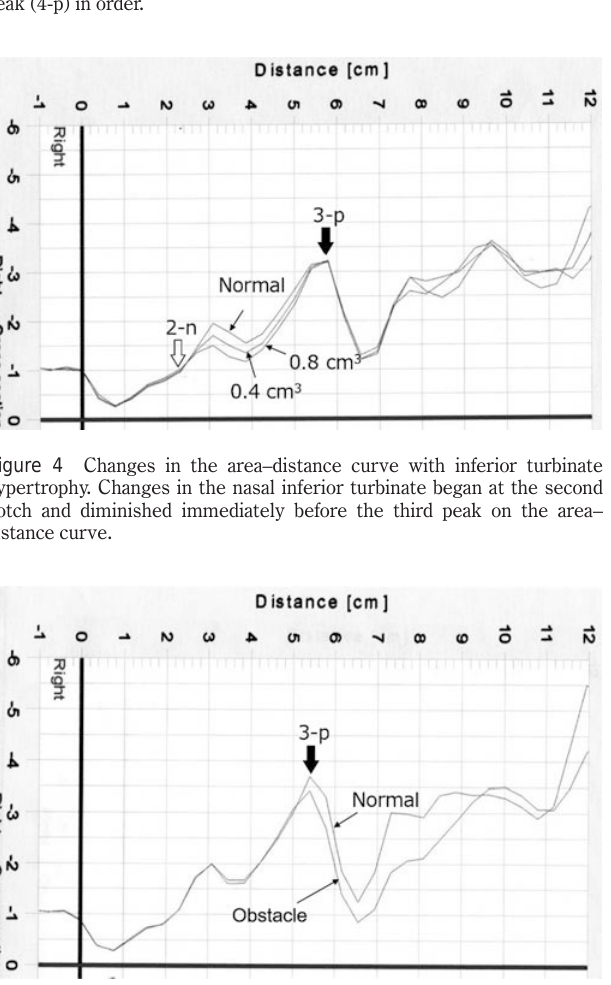
Figure 5 Changes in the area–distance curve with an obstacle at the posterior edge of the nasal septum. The obstacle at the posterior edge of the nasal septum in the model was identified at the third peak on the